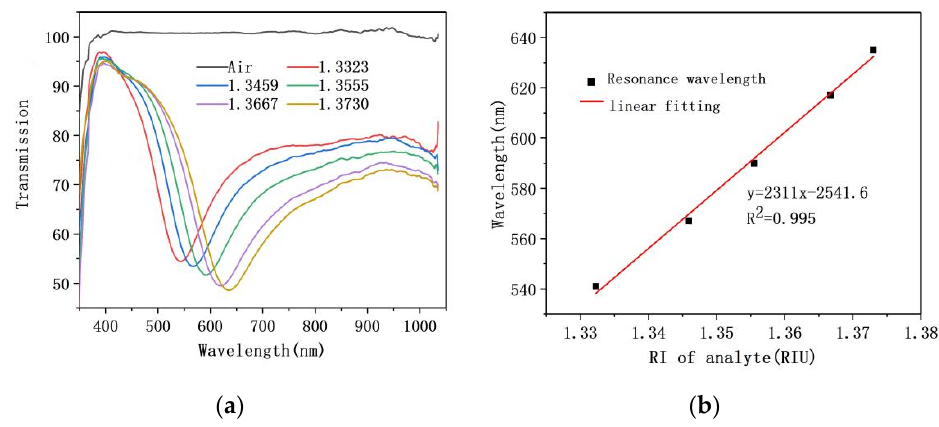
Figure 8. ( a ) The resonance spectrum of fiber/Ag film SPR sensor with glucose solution as analyte; ( b ) The sensitivity fitting